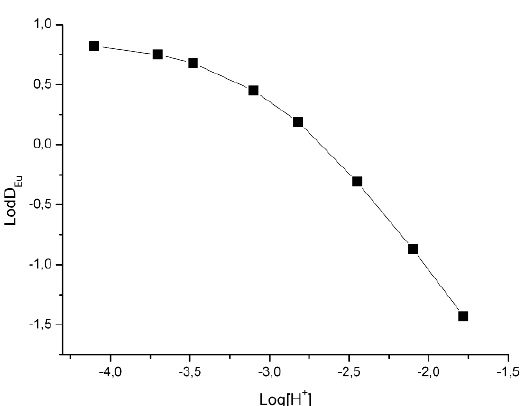
Figure 4. Simultaneous extraction of lanthanides(III) from 4 M NH NO solutions with compounds 1 - 10 in 4 3 1,2-dichloroethane. Initial extractant concentrations are 0.01 M for 1-8 , 10 and 0.02 M for phosphine oxide Ph P(O)Et 9 . 2